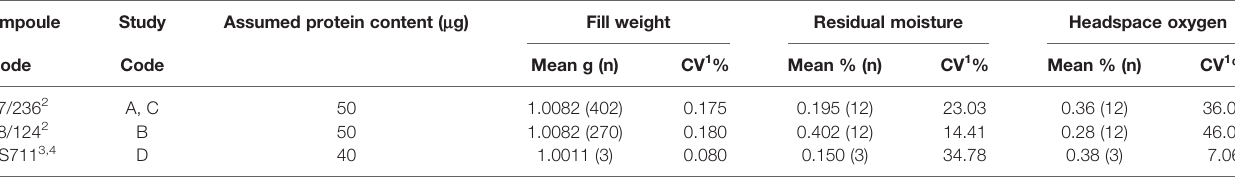
TABLE 4 | Characteristics of the lyophilized preparations.